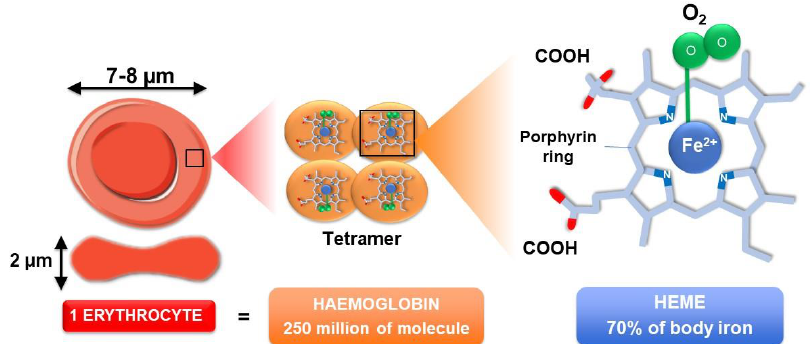
Figure 2. Erythrocyte structure and content. One single erythrocyte contains about 250 million haemoglobin molecules. Haemoglobin, the protein responsible for oxygen transport, is a tetramer composed of 4 globin chains. Each globin chain contains one heme molecule responsible for the binding of one oxygen molecule (O 2 ). Heme consists of a porphyrin ring centred by one atom of iron (Fe 2+ ). Oxygen strongly binds to this iron atom. Almost two-thirds of the body iron (about 2.5 to 36 g) is localised in haemoglobin of circulating erythrocytes.